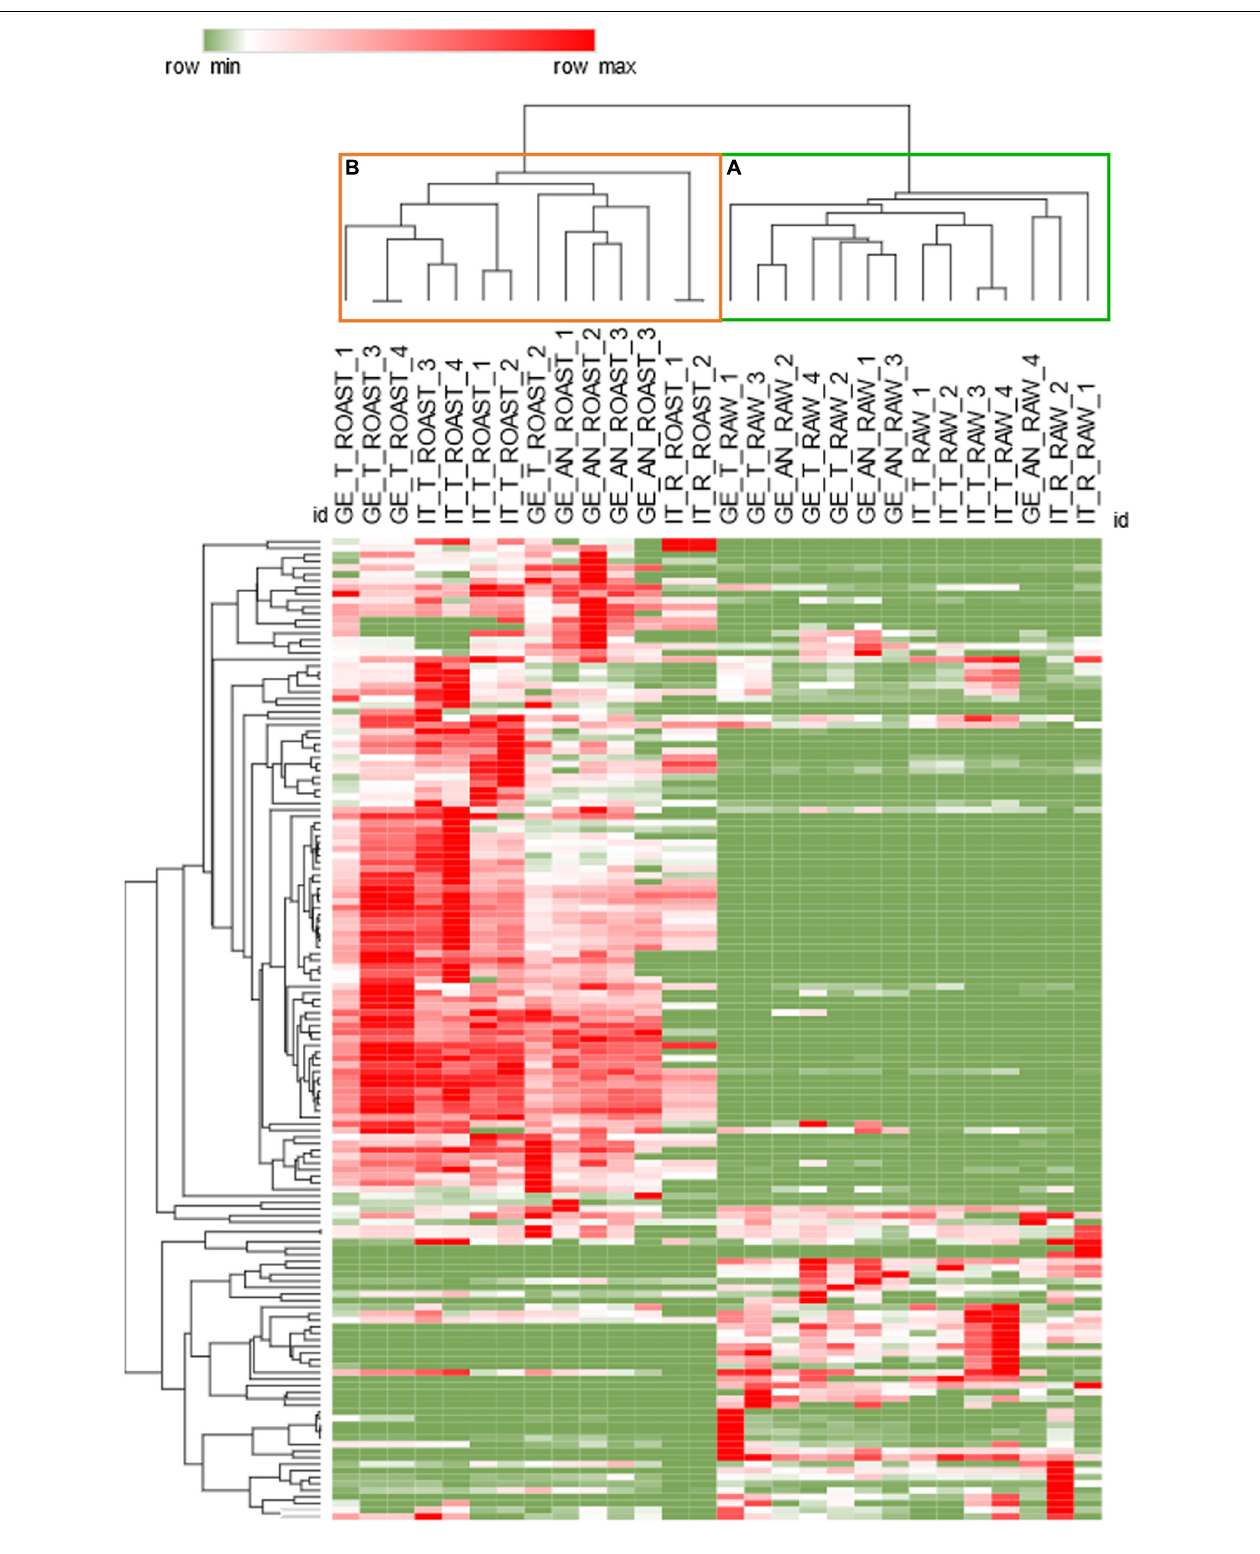
FIGURE 3 | Hierarchical clustering based Pearson’s correlation for raw (B) and roasted (A) samples. Response data obtained by averaging batch replicates were Z-score normalized; heat-map visualization is in a color scale from green to red.